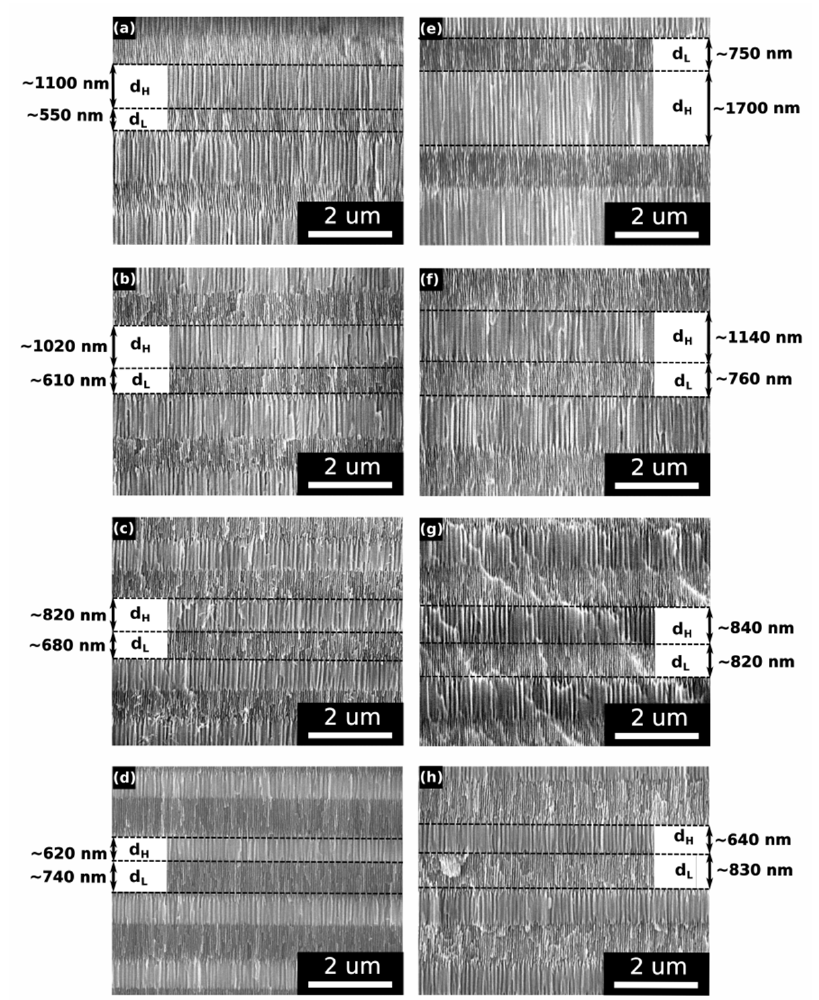
Figure 7. SEM images of upper d H and d L segments in the PAA_t L -t H DBRs: ( a ) PAA_480-180, ( b ) PAA_520-140, ( c ) PAA_560-100, ( d ) PAA_600-60; and in the PAA_C L -C H DBRs: ( e ) PAA_2989-5017, ( f ) PAA_3309-3661, ( g ) PAA_3469-2598, ( h ) PAA_3653-1535.